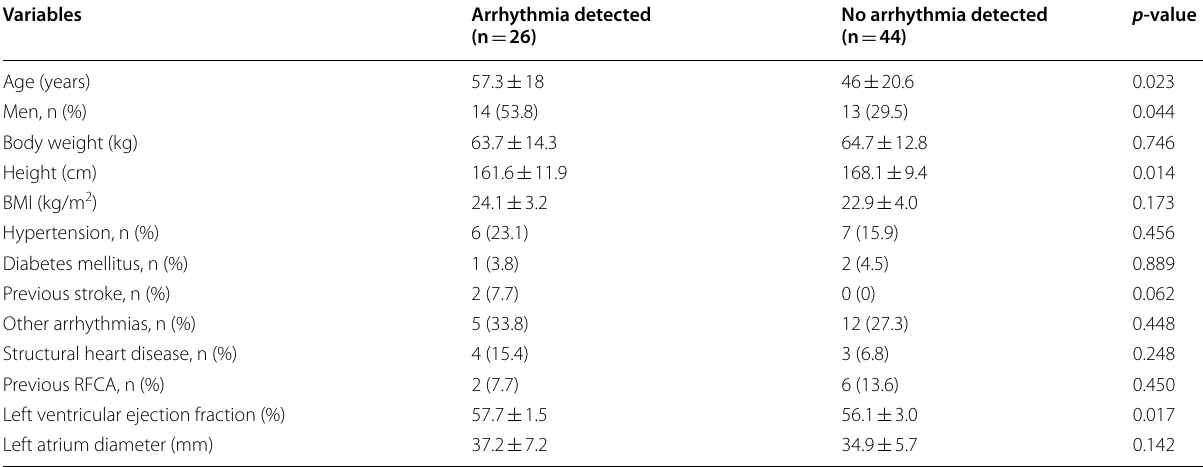
Table 1 Baseline characteristics of patients with documented arrhythmia by implantable loop recorder (ILR) and not documented